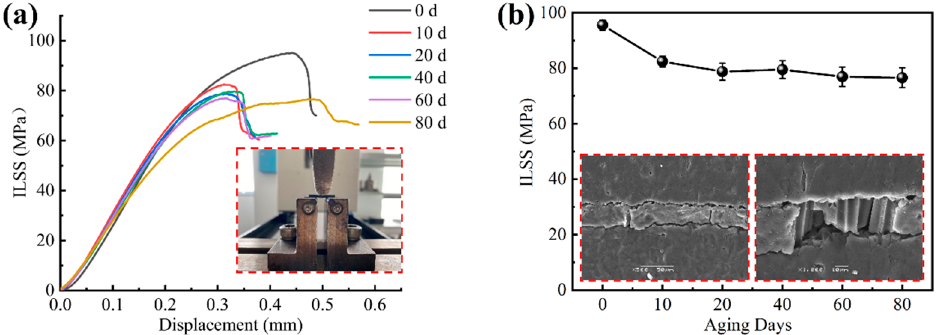
Figure 17. ( a ) Interlaminar stress–displacement curve; ( b ) interlaminar shear strength versus UV aging time curve.